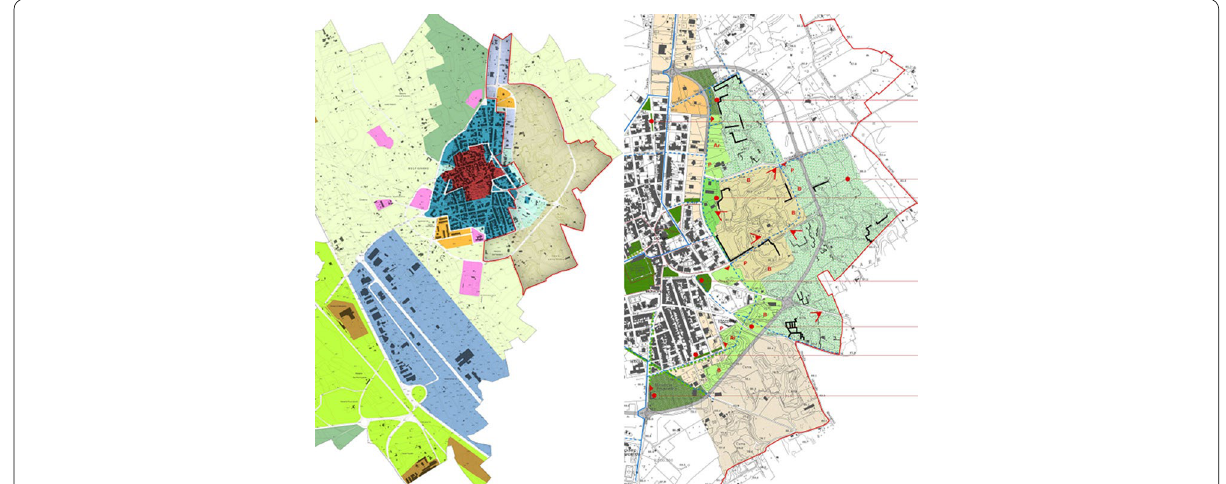
Fig. 5 The Melpignano Quarry Park. The City-Country Pact strategy focuses on regenerating the Melpignano quarry areas (left image). The Quarry Park master plan (right) shows different open spaces used for urban forestation (light green near settlement), organic farming (light green dots), and recreational and leisure uses within the quarries (dark yellow). Source: Municipality of Melpignano, extracts from table 15 1:5000, north–south oriented) and table 10dx (original content scale 1:5000, north–south oriented) of the Adaptation of the Municipal Plan to the PPTR